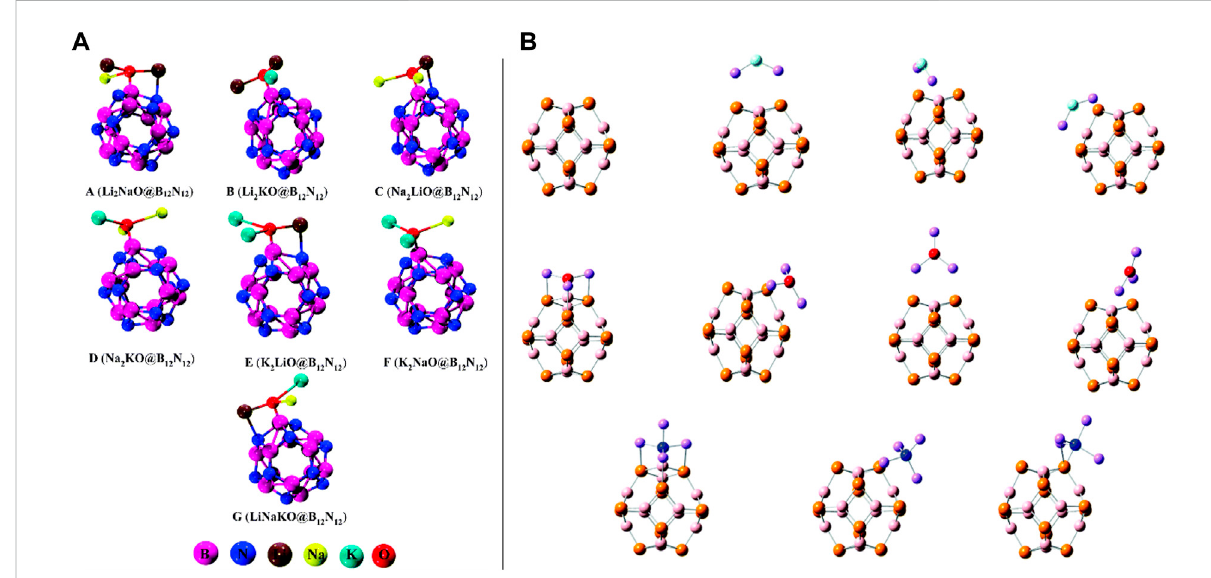
FIGURE 2 (A) Optimized geometries of the most stable complexes of mixed-superalkali-doped B 12 N 12 adapted from Bano et al. (2022) with permission from the Royal Society of Chemistry; (B) optimized structures of C 6 Li 6 -nCO 2 complexes (front and side views) for n = 1 – 6 adopted from Srivastava (2019b) with the permission of